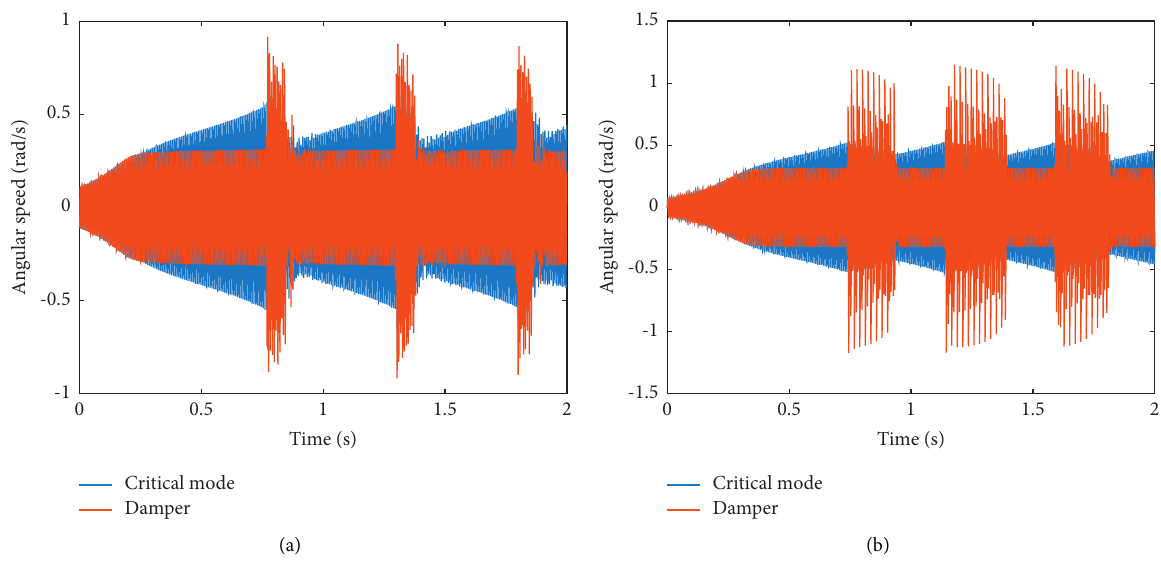
Figure 5: Time response of the damper (physical) and structure (physical amplitude at the damper) with shocks, using a CMS-reduced model (a) and a modal-reduced model (b).